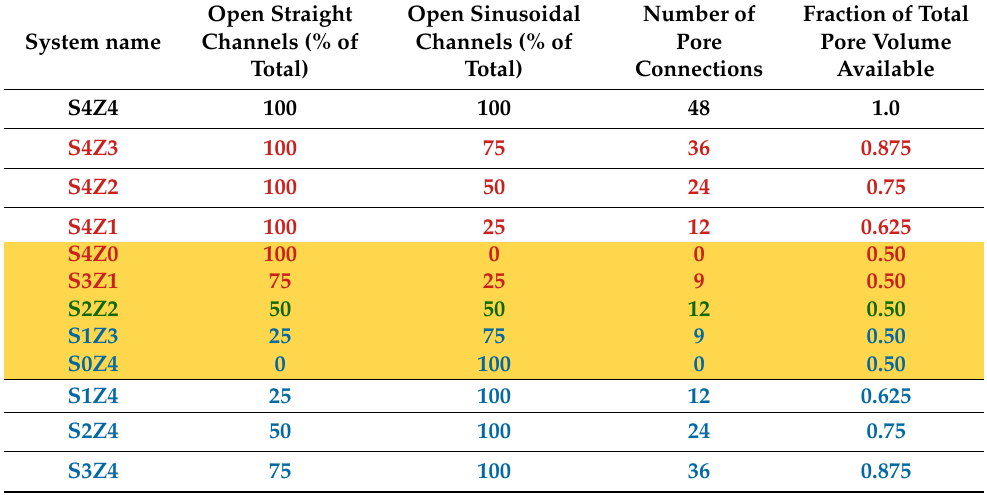
Figure 2. Schematic showing the definition of different systems. Each vertical line in magenta shows free straight channels while blue horizontal lines show free zigzag channel. The blocked channels are marked by an absence of the corresponding line. S4Z4 corresponds to the unmodified silicalite with no pore blocked with methane.